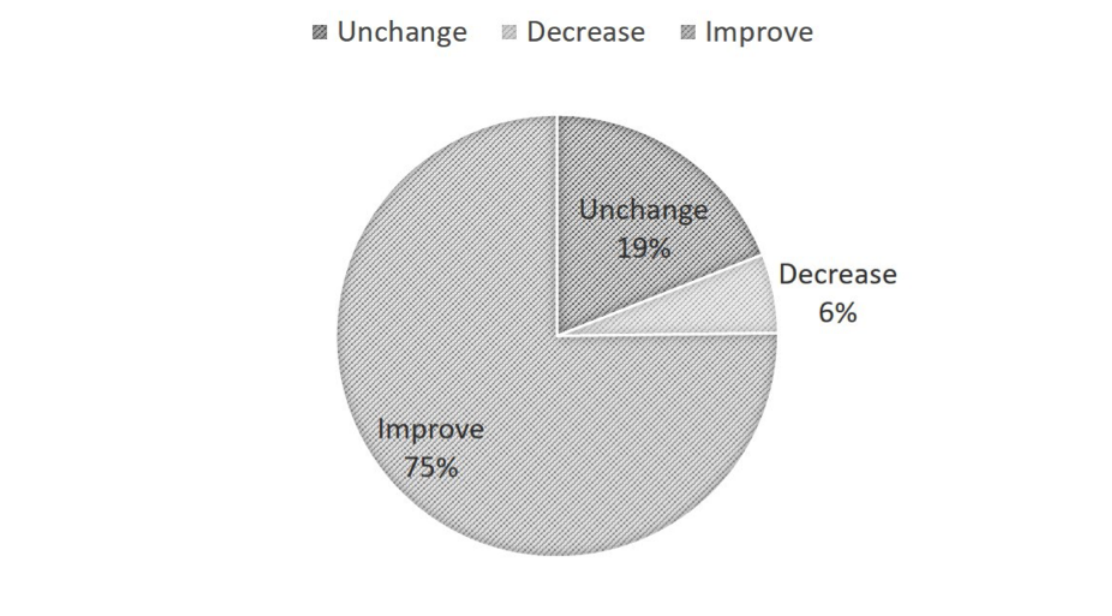
Figure 7. % of decreased, improved, and unchanged ratings in the conversation (from the 1st iteration to the